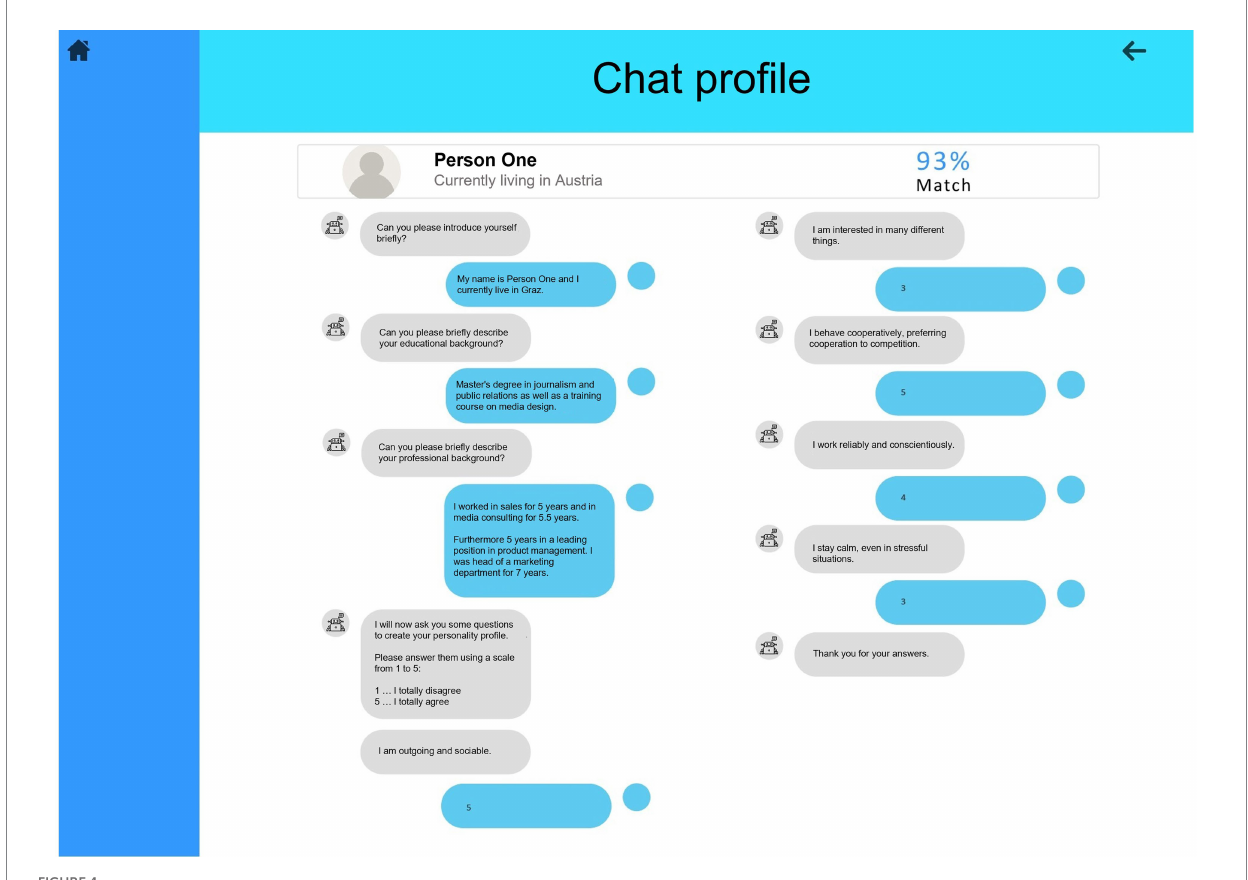
FIGURE 4 Dashboard level 3 – chatbot